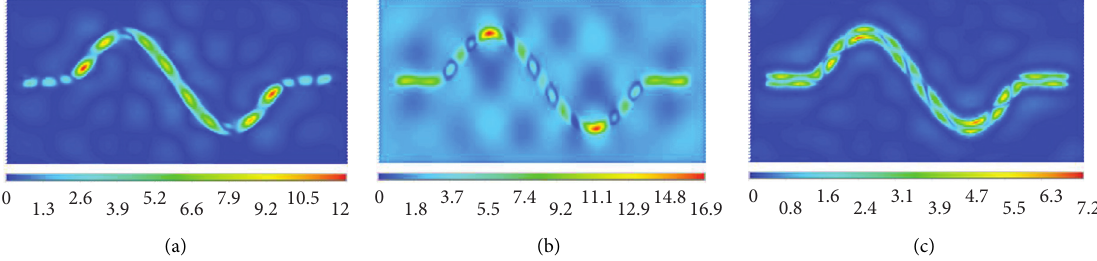
Figure 47: SH wave incident ( C